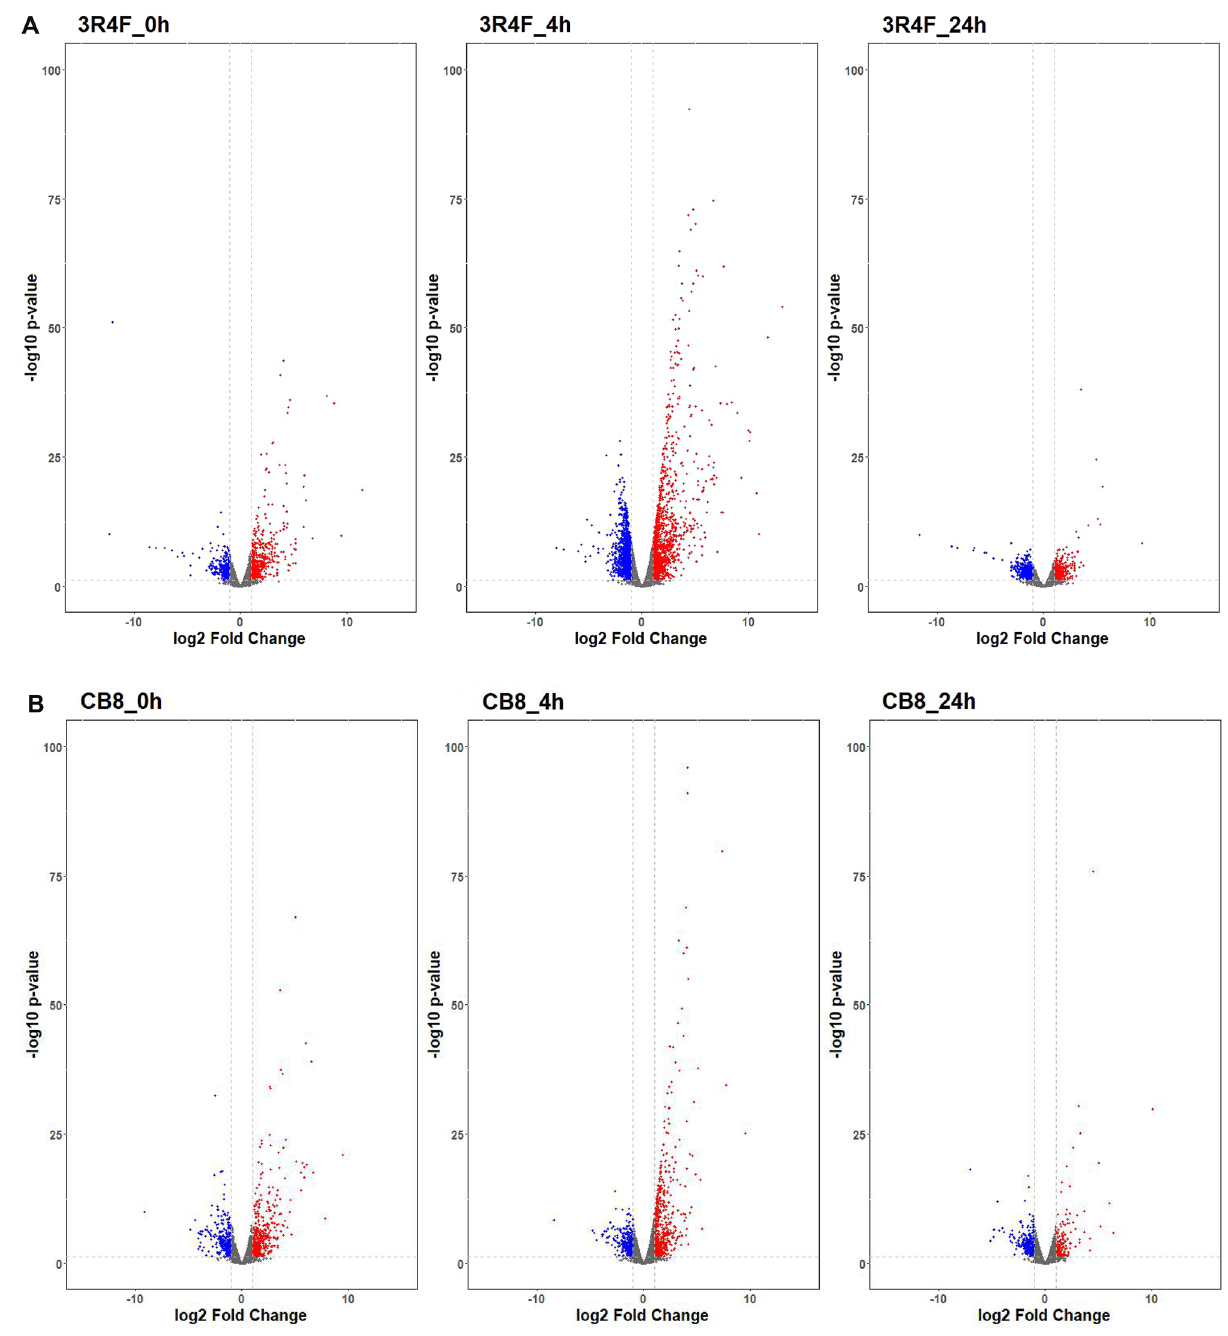
Figure 4. Volcano plots for mainstream smoke (MS) exposure generated by reference and commercial cigarettes. A Exposure to 1/500 MS from 3R4F cigarettes for 1 h, compared with the air control, the number of differential genes changes at three time points, 3R4F_0h: recovery 0 h after exposure to 1/500 MS from 3R4F cigarettes for 1 h; 3R4F_4h: recovery 4 h after exposure to 1/500 MS from 3R4F cigarettes for 1 h; 3R4F_24h: recovery 24 h after exposure to 1/500 MS from 3R4F cigarettes for 1 h. B Exposure to 1/500 MS from CB8 cigarettes for 1 h, compared with the air control, the number of differential genes changes at three time points. CB8_0h: recovery 0 h after exposure to 1/500 MS from CB8 cigarettes for 1 h; CB8_4h: recovery 4 h after exposure to 1/500 MS from CB8 cigarettes for 1 h; CB8_24h: recovery 24 h after exposure to 1/500 MS from CB8 cigarettes for 1 h. The X-axis displays Log2 of the fold change (FC), and the Y-axis displays -Log10 of the adjusted p-value (pFDR). The dashed horizontal lines represent the 0.05 pFDR threshold. The vertical dashed line shows + 2 and − 2 times the change threshold. Blue dots represent significant RNA features at pFDR < 0.05 and FC < − 2, and red dots represent significant RNA features at pFDR < 0.05 and FC > +